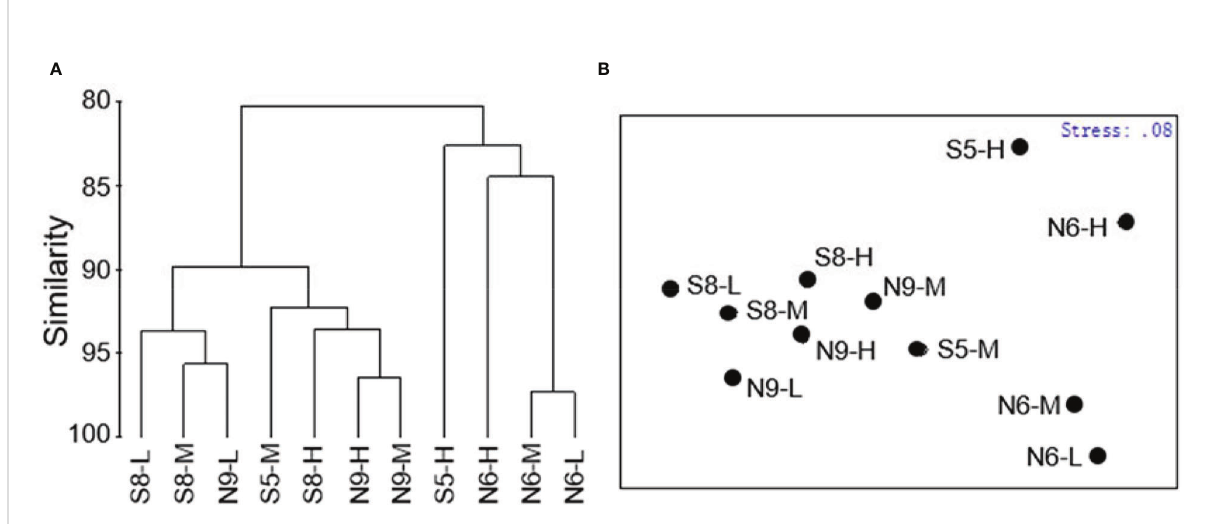
FIGURE 5 (A) Cluster and (B) non-metric multidimensional scaling (NMDS) ordinations of the macrobenthos functional